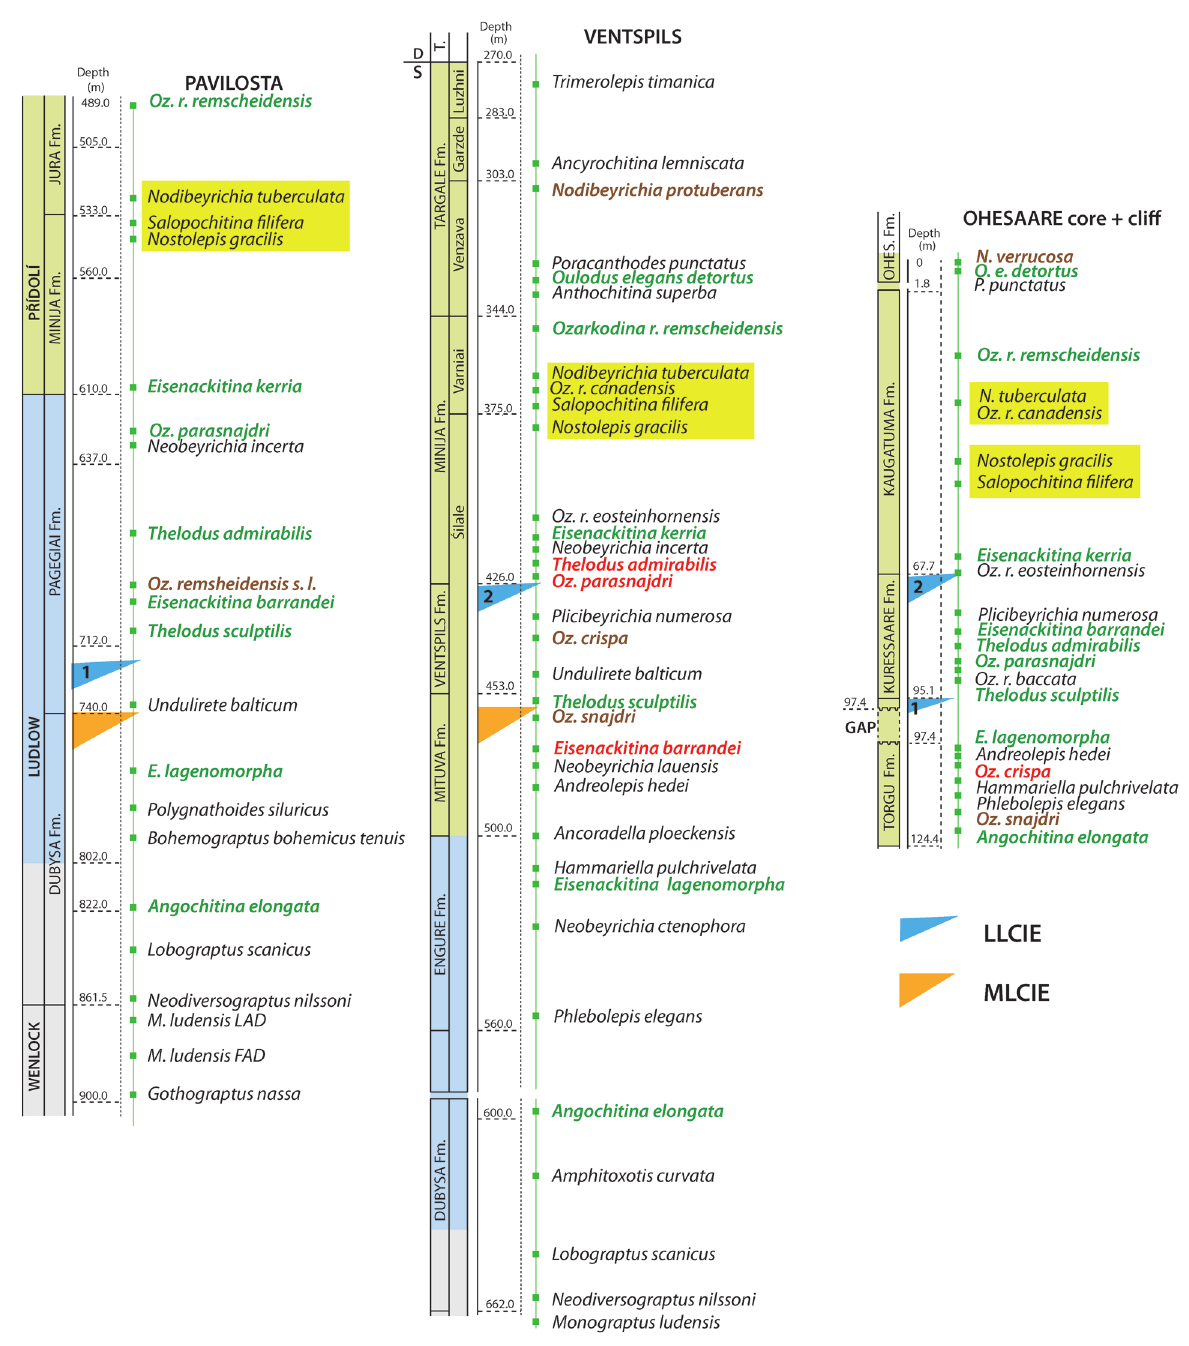
Fig. 3. First appearance datums of the upper Silurian biozonal index species in the three core sections plotted according to actual occurrence depths and their synchroneity evaluated based on the chemostratigraphical time levels. Font colours are as follows: black – normal synchronous occurrences; green – in general the same but some comments are needed; red – for some reason the occurrence is abnormal; brown – the occurrence may be doubtful due to problems with taxonomy, identification, etc. The FADs of a group of typical mid-P ř ídolí index species are highlighted with yellow background. Abbreviations: LLCIE – Late Ludfordian Carbon Isotope Excursion twin peaks (1 and 2). MLCIE – Mid-Ludfordian